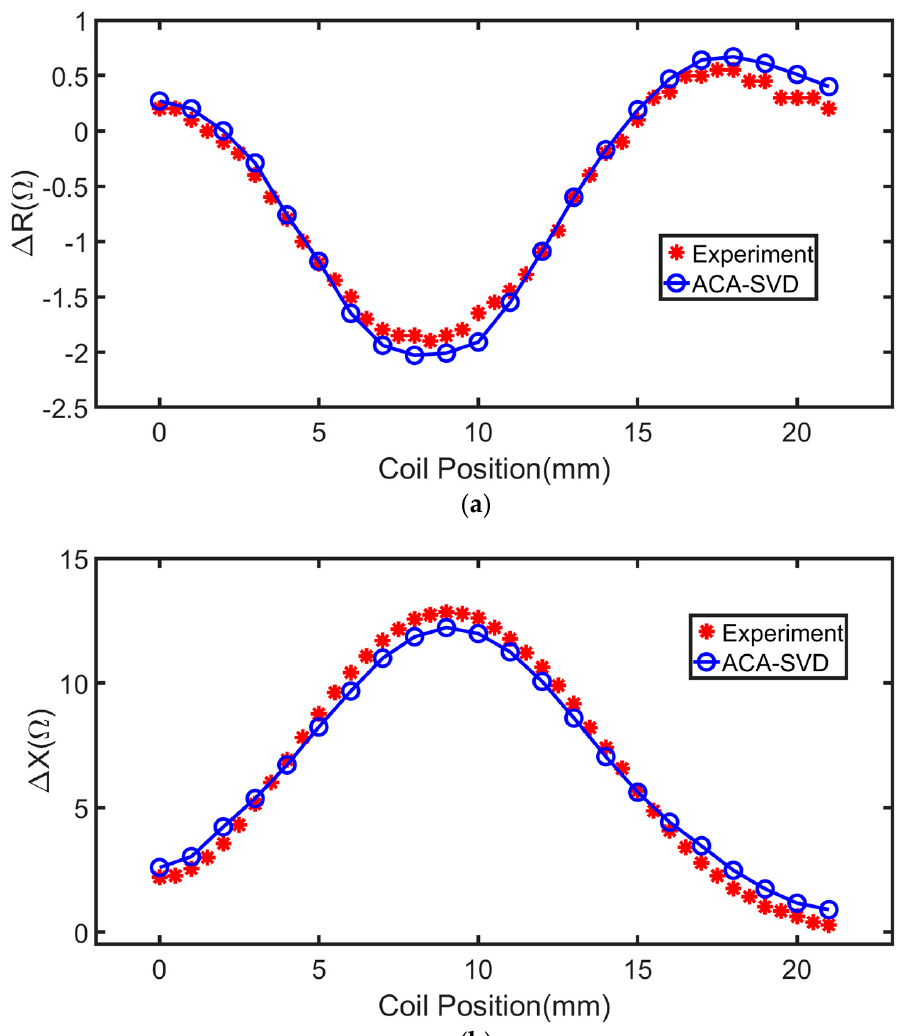
Figure 5. Impedance variations of scanning the coil with a finite cross section above the conducting plate with a surface slot achieved by the ACA-SVD based BEM solver and experiments, respectively. ( a ) Resistance variations. ( b ) Reactance variations.